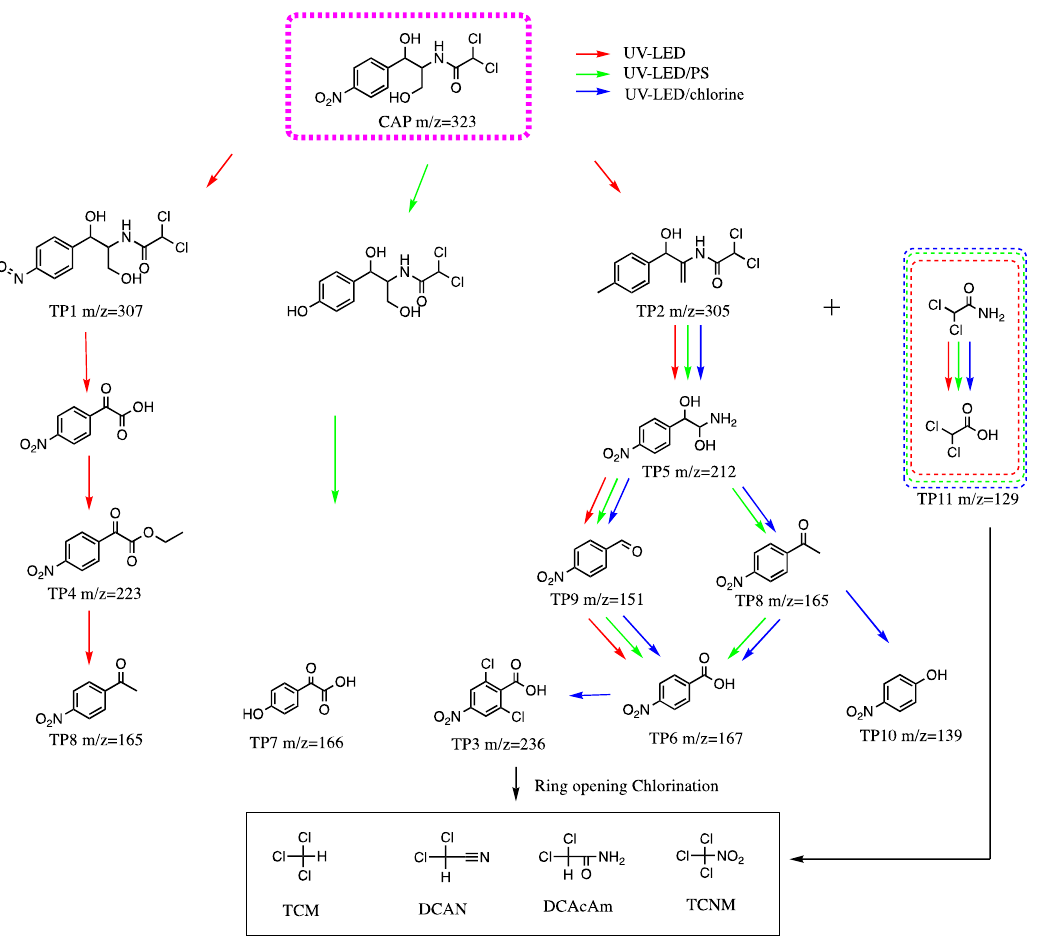
Scheme 1. Proposed degradation pathways of CAP using UV-LED, UV-LED/PS and